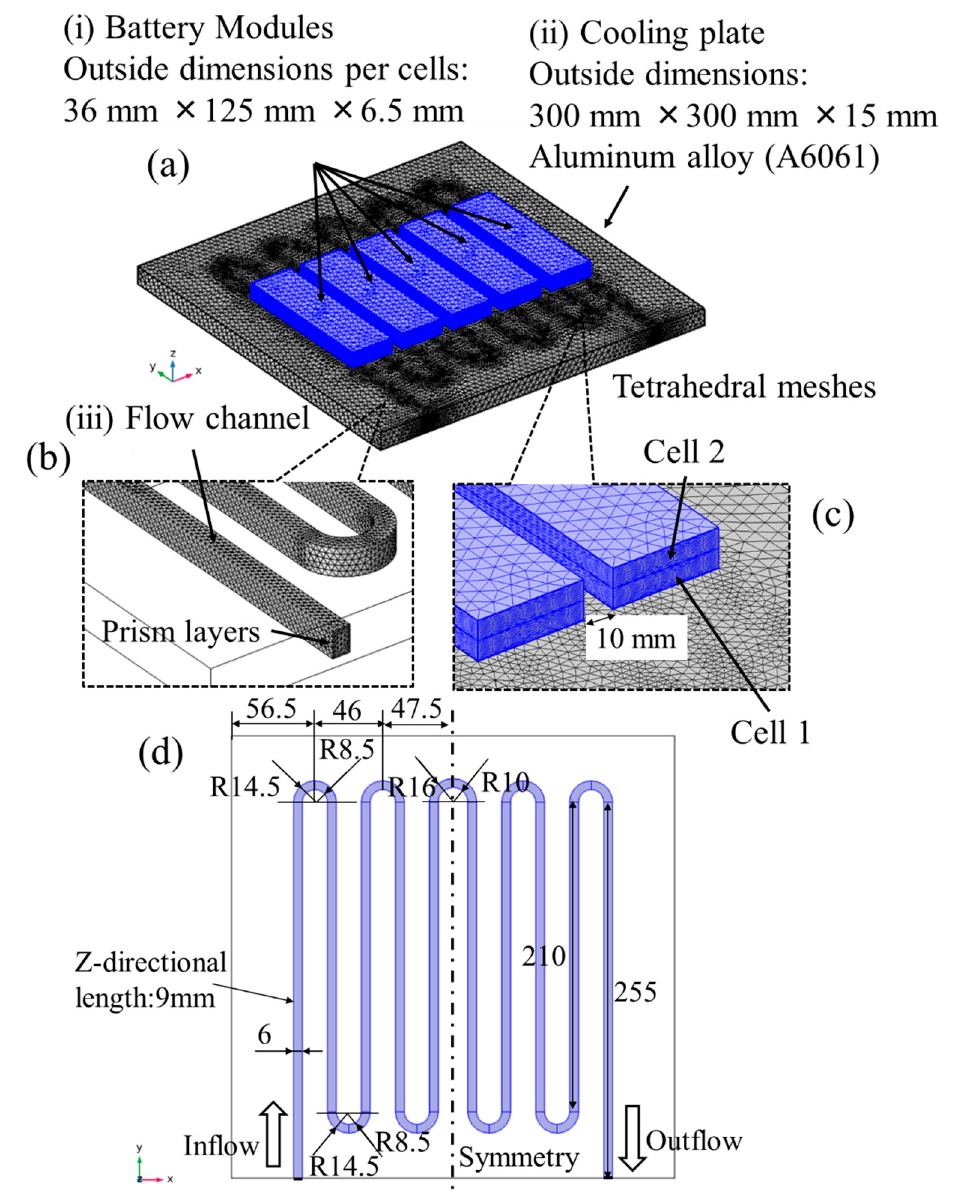
Figure 4. The overview of the calculational meshes and the geometry of the flow channel in the cooling plate. ( a ) shows the whole overview of the calculational meshes, ( b,c ) show the detail view of the flow channel and the cells, and ( d ) shows the geometry of the flow channel in the cooling plate.